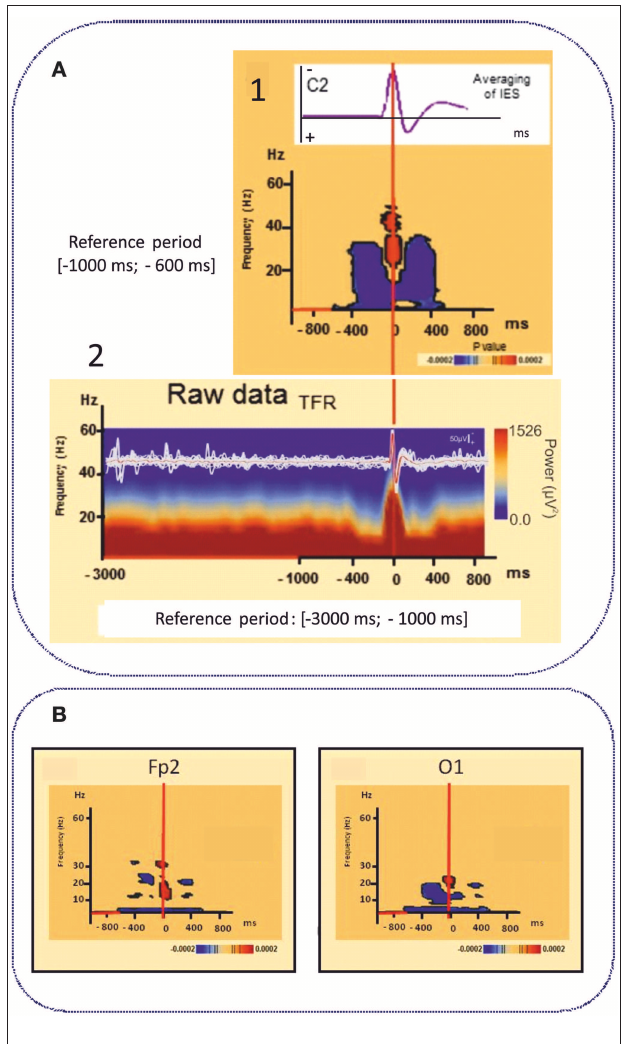
FIGURE 4 | Time frequency analyses of functional disorganization in the epileptogenic zone (A) in in remote regions (B) . A1 Averaging of the selected right centro-temporal IES in typical ECTS at electrode C2 [HD EEG, 64 electrodes positioned according to the 10/10 international system, band pass (0.53 − 15Hz), notch filter (50Hz)]. Bellow, Time frequency statistical analysis at electrode C2 for the same patient [reference period ( − 1000; − 600ms), ( p